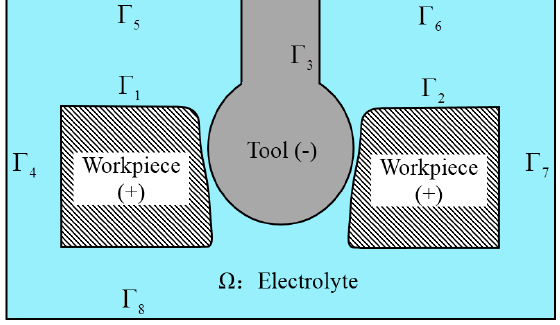
Table 1. Parameters applied in the simulation